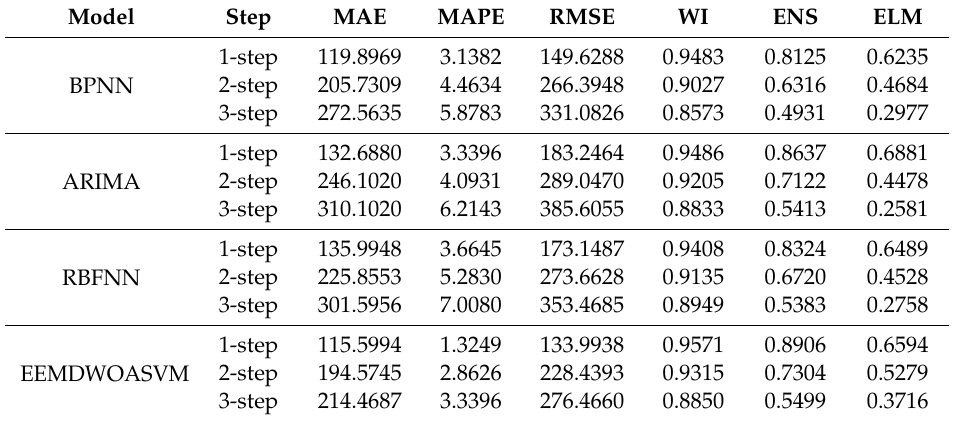
Table 5. Forecasting results of the proposed model and other traditional models using 60 min electric load data from Queensland.